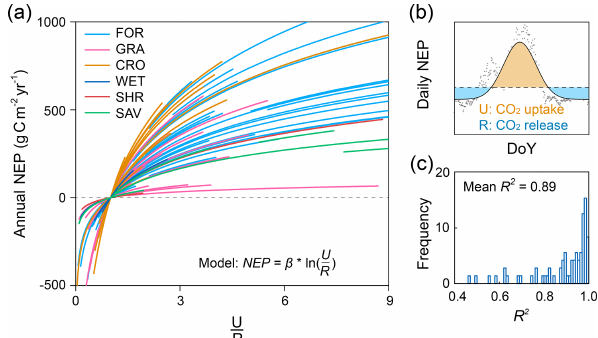
Figure 1. Relationship between annual NEP and U /R for 72 ) ). (a) Dependence FLUXNET sites (of the form NEP = β · ln ( U R of annual NEP on the ratio between total CO 2 exchanges during net uptake ( U ) and release ( R ) periods (i.e. U /R ). Each line rep- resents one flux site with at least 5 years of observations. (b) Con- ceptual figure for the decomposition framework introduced in this study. Annual NEP can be quantitatively decomposed into the fol- lowing indicators: NEP = U − R . (c) Distribution of the explanation of U /R on temporal variability in NEP ( R 2 ) for FLUXNET